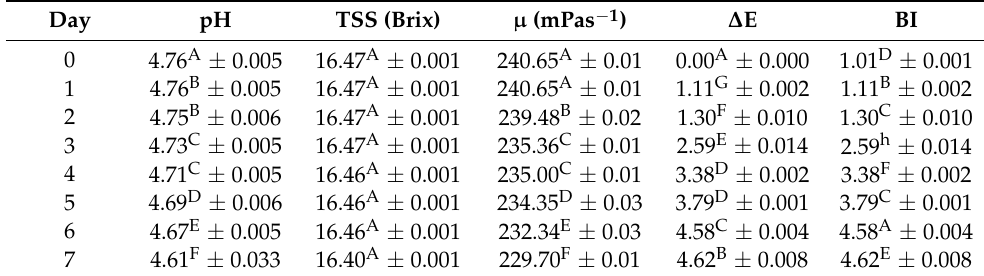
Table 3. Analysis of variance for the effect of storage time on the physicochemical properties of a laban